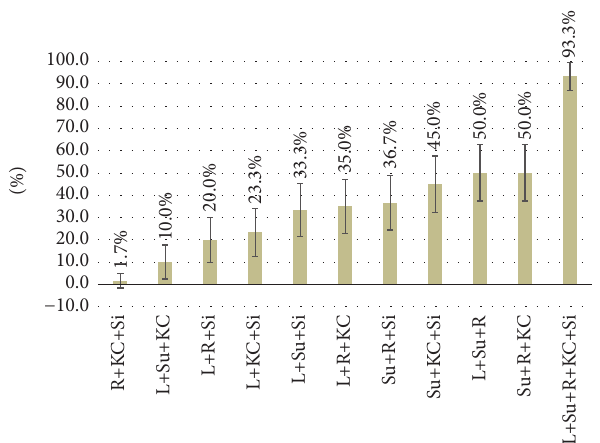
Figure 5: Comparison of complete visualization rates of different position combinations. L: left lateral; Su: supine; R: right lateral; KC: knee-chest; Si: sitting.